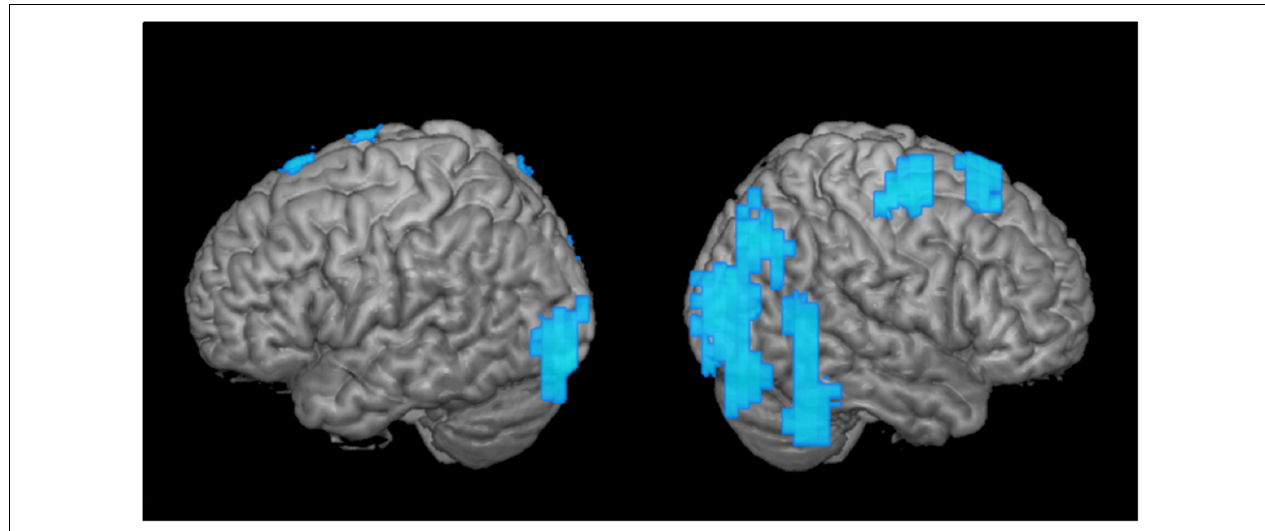
FIGURE 3 | Greater disengagement observed in the contralesional hemisphere. Statistically significant changes in activation maps from first to the second time point when the tumor was located in the proximity of the primary MC (shown left; displayed are left-sided tumors with right index finger activation maps, and right-sided tumors with left index finger activation maps that were flipped along the x-axis). Blue areas indicate decreased activation at the second time point of the ipsi- (left) and contralesional (right) activation maps in patients with frontal-insular-temporal tumors. The level of significance was set at p < 0.01; results were corrected at a cluster level of 20 voxels.